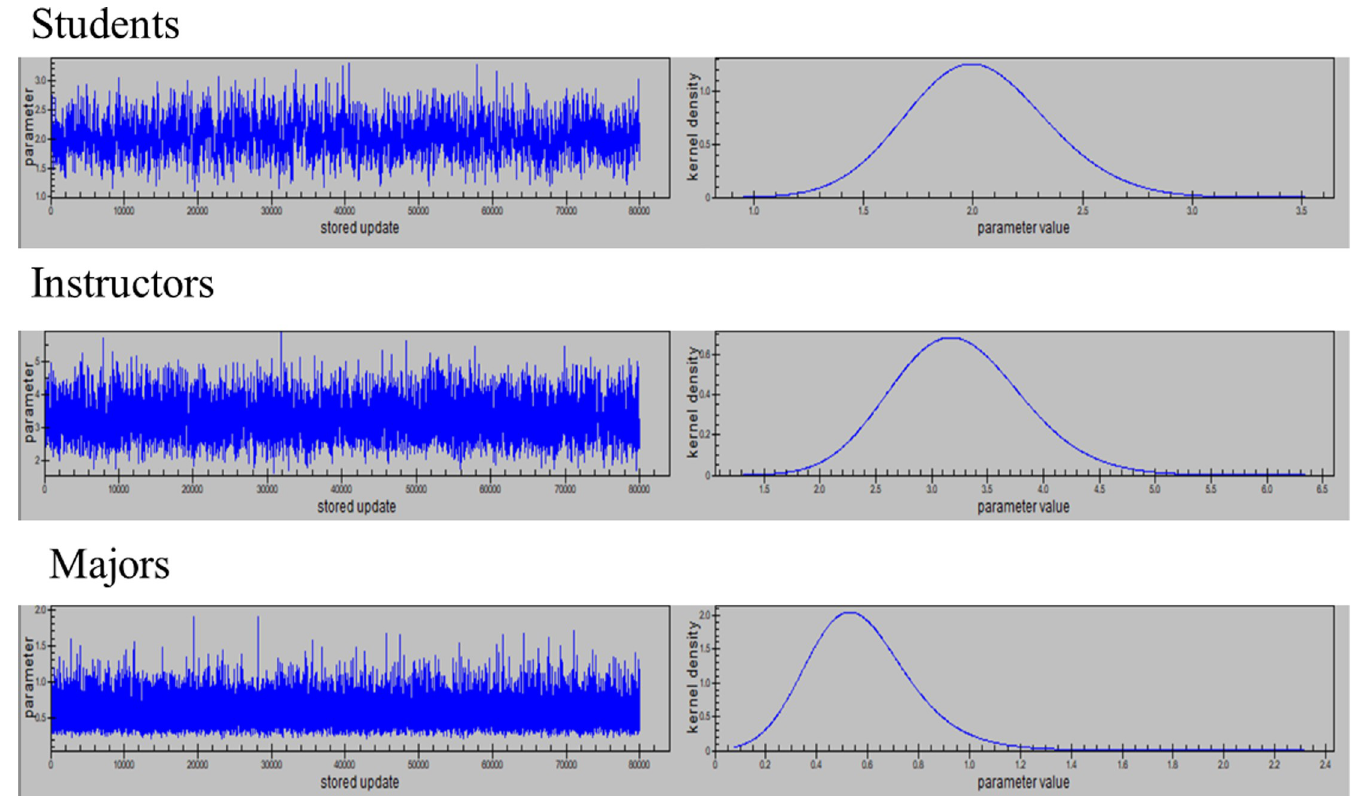
Fig 4. Markov Chains and posterior distributions for variance components when modeling probability of getting GPA 2.0 or better.